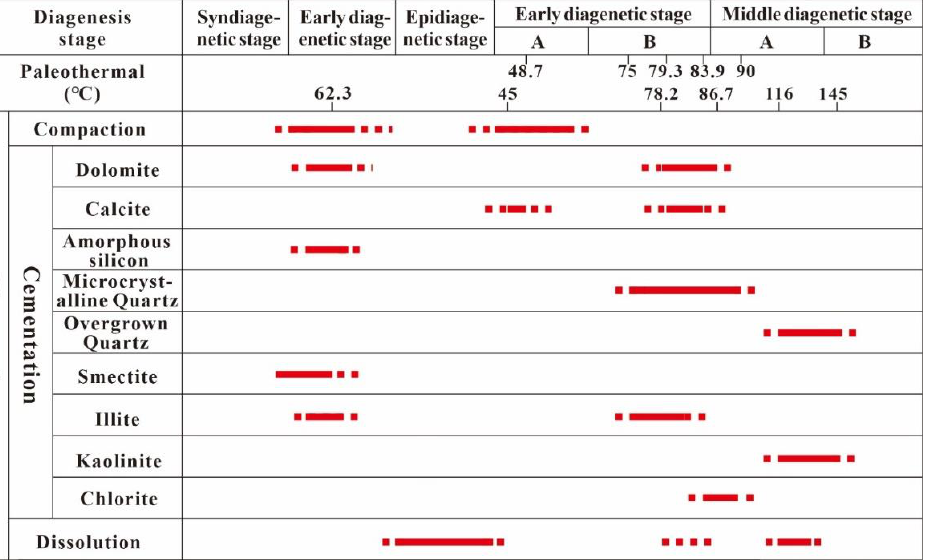
Figure 15. The sequence of the diagenetic evolution of reservoirs.